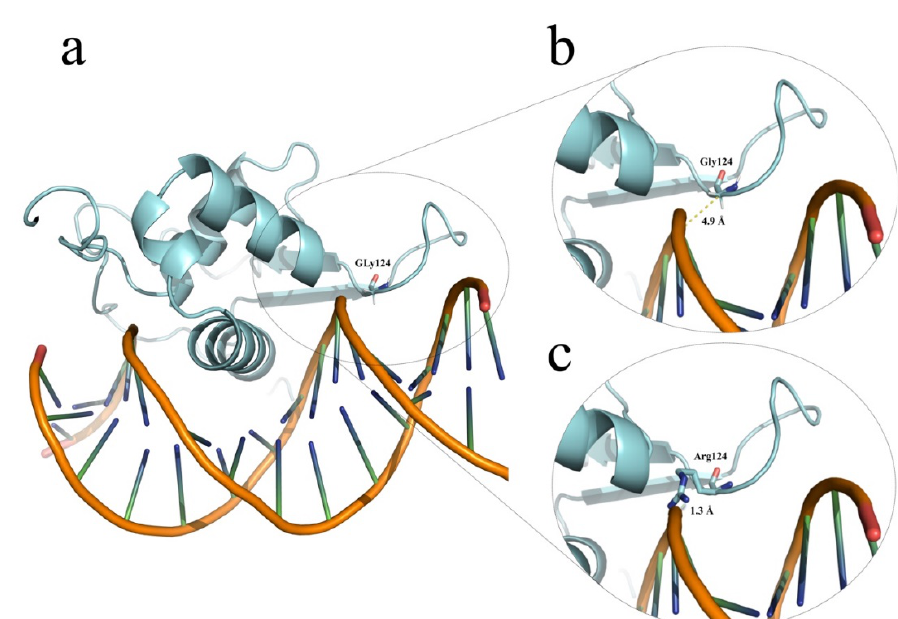
Figure 1. Partial FOXE1 modeling. ( a ) Schematic representations of our in silico modeling of FOXE1 in contact with DNA, as obtained with the PyMOL software. ( b ) The close-up shows a distance of 4.9 Å separating Gly124 from the minor groove of DNA. ( c ) In contrast, the model for the protein with a Gly124 to Arg124 substitution identified in HC-266 shows only 1.3 Å separating Arg124 from DNA; this leads to clash contacts, which could destabilize or alter the DNA-binding affinity of the mutant FOXE1. The 3D model was structurally aligned with the crystallographic structure of interleukin 1 (PDB code: 2C6Y).